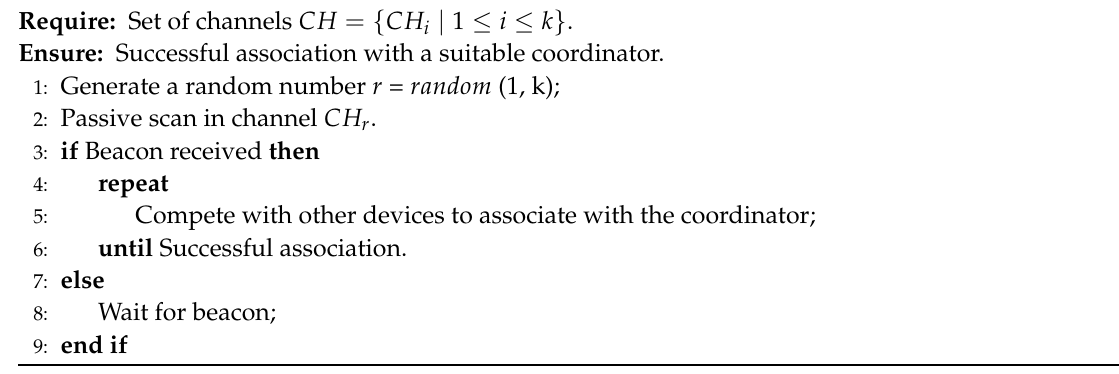
Algorithm 2 A new association scheme for